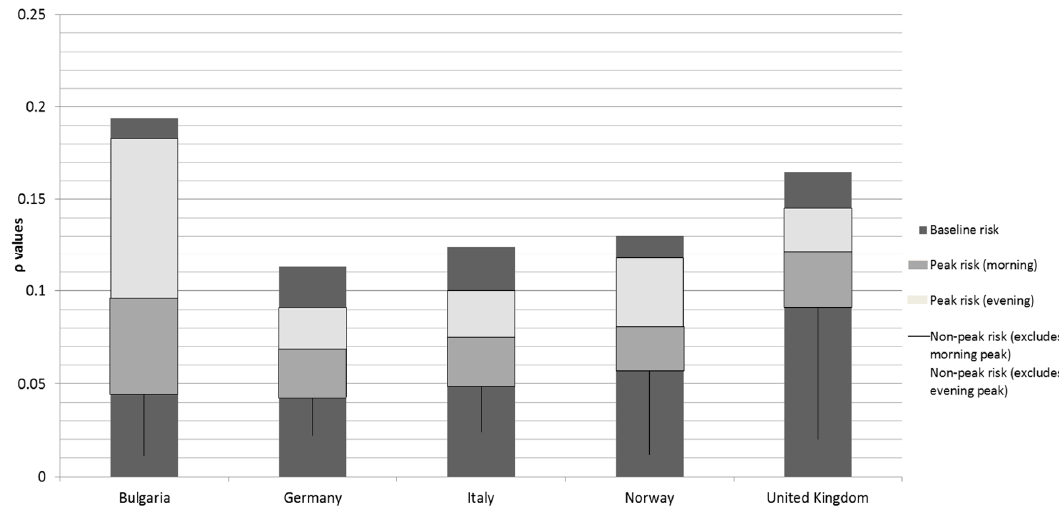
Figure 4. Baseline risks, peak risks and non-peak risks (per household).